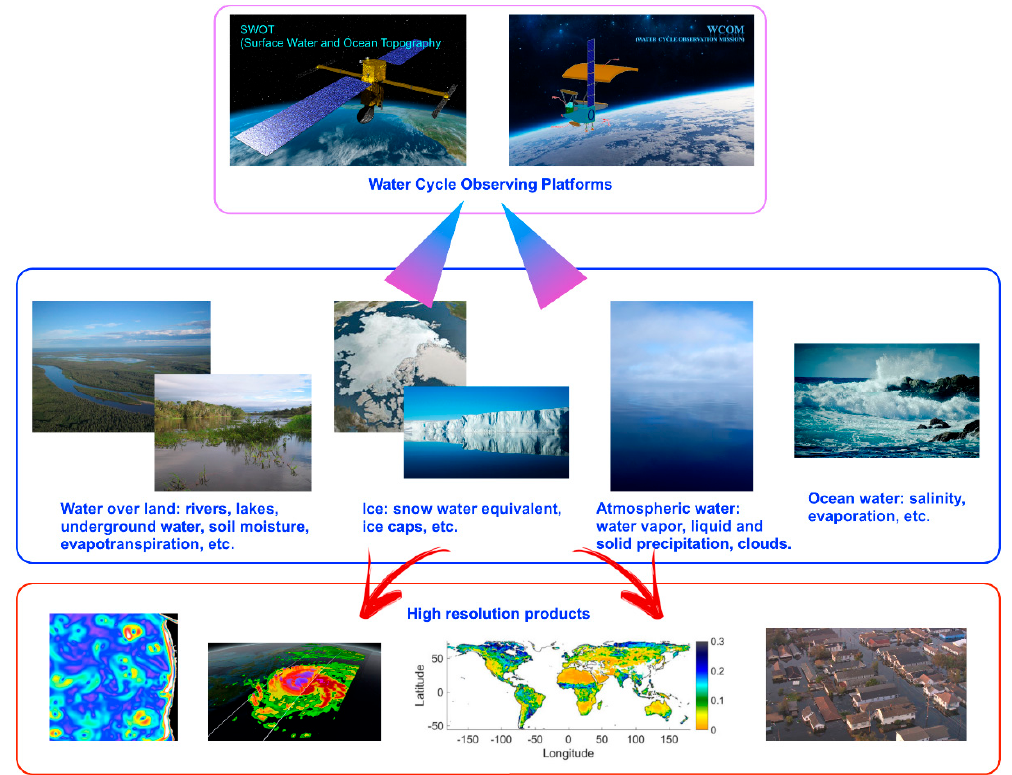
Figure 6. Concept of the planned missions for the global water cycle observation.